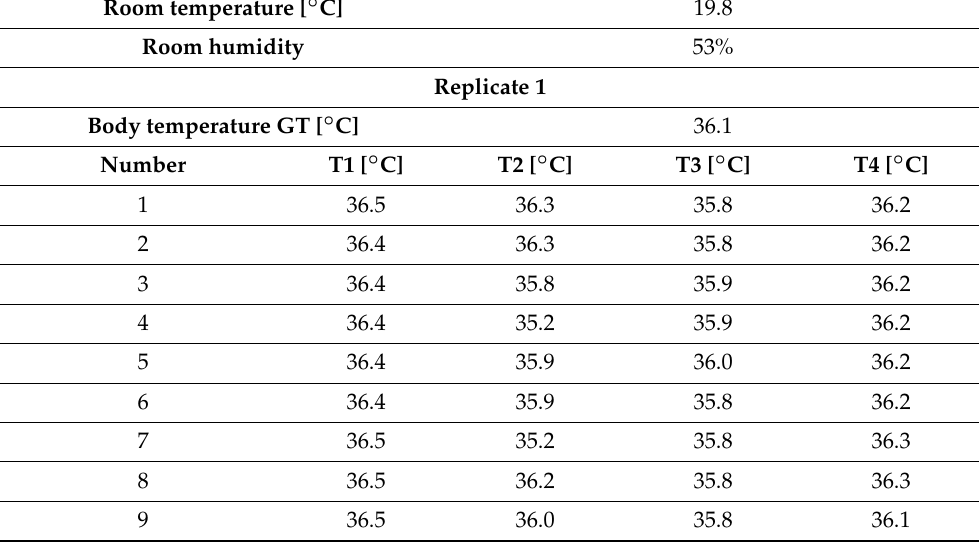
Table A1. Intra- and inter-rater reliability experiment. Subject 1 body temperature